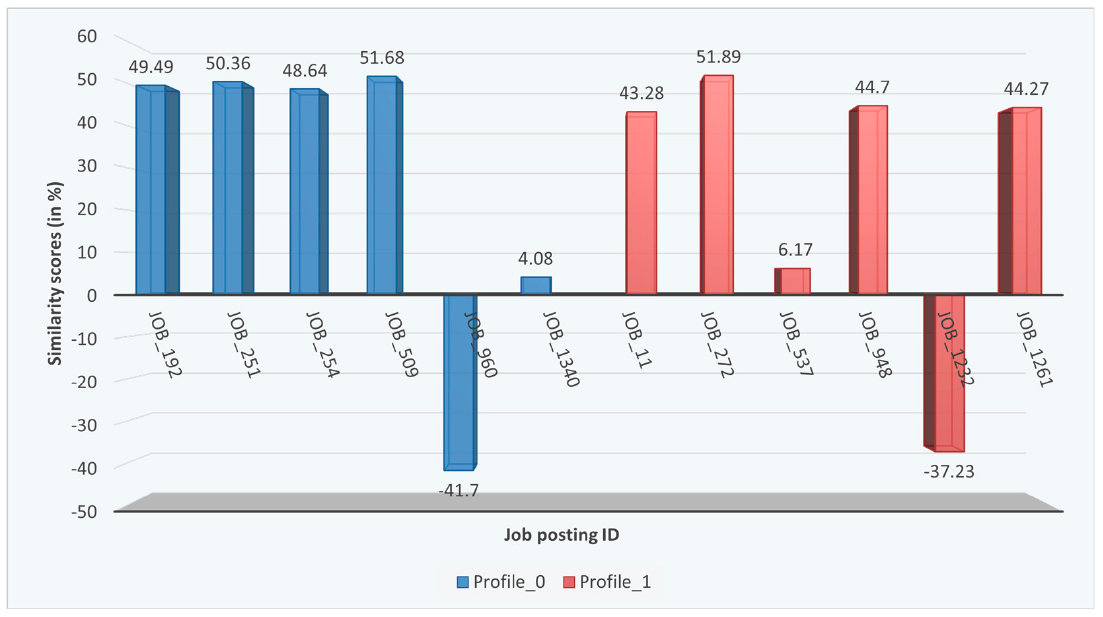
Figure 10. A sample of the overall calculated similarity scores between user profiles and job postings. Similarities above a predefined threshold are used to create corresponding relations in the knowledge graph. Negative similarity scores are caused by the angle value between document vectors, which results in a negative cosine value of that angle when calculating the cosine similarity.